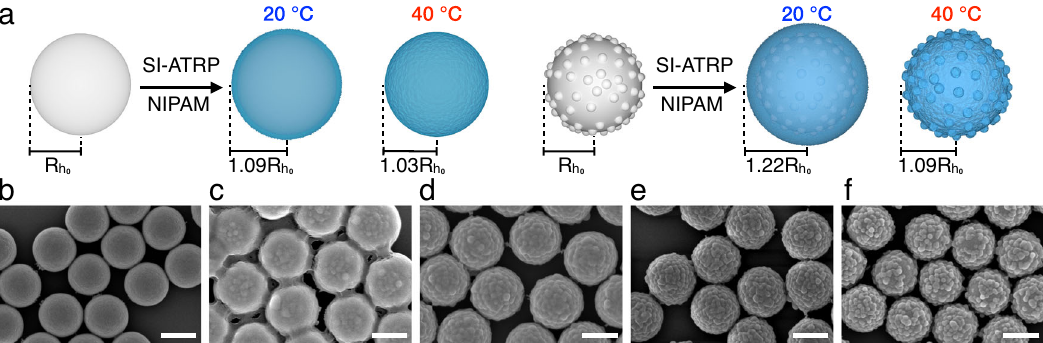
Fig. 1 PNIPAM-grafted smooth and rough silica particles. a Schematics of the PNIPAM-grafted smooth (SM) and rough (RB) particles at 20 °C and 40 °C. R h is the radius of smooth or rough particles before polymerization. b – f Scanning electron microscopic images of four PNIPAM-grafted 0